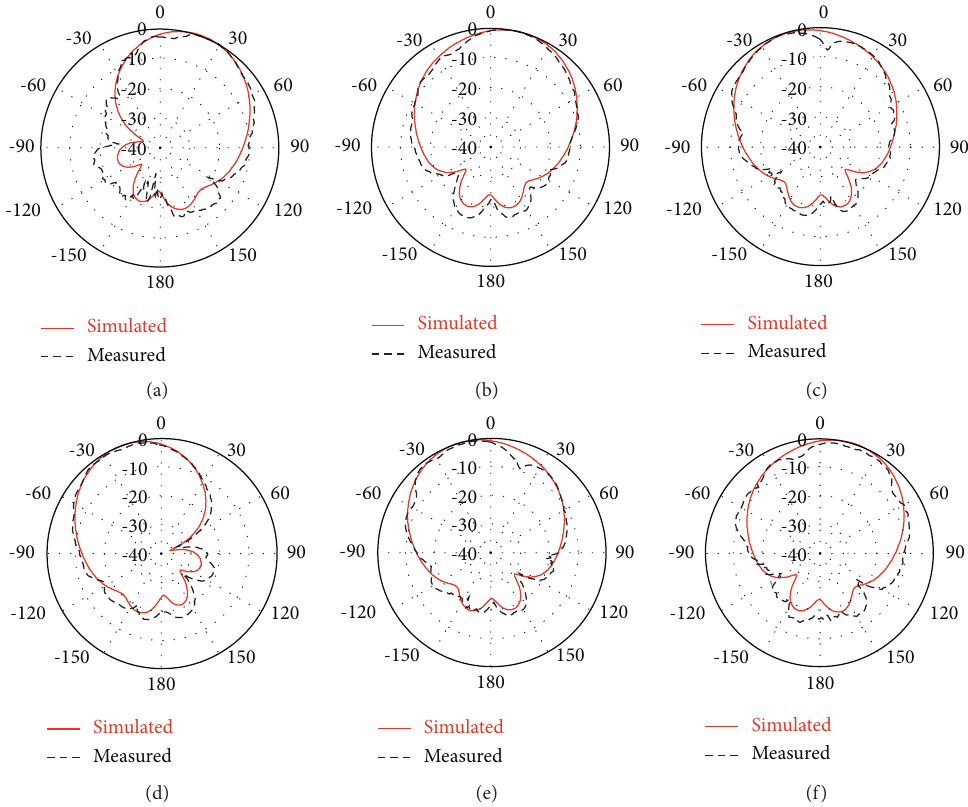
Figure 11: Simulated and measured radiation patterns of the proposed antenna in the xz -plane ( ϕ � 0 ° ) at 5.82GHz: (a) State 1, (b) State 2, (c) State 3, (d) State 4, (e) State 5, and (f) State